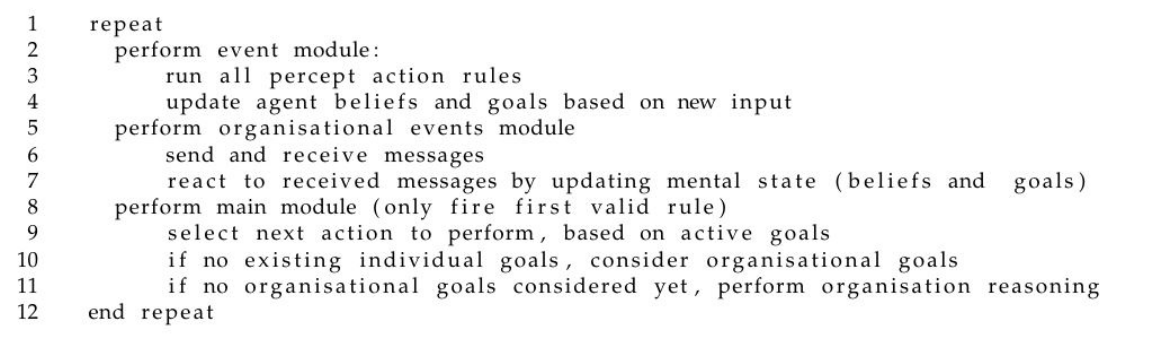
Figure 5. Agent reasoning cycle in implemented